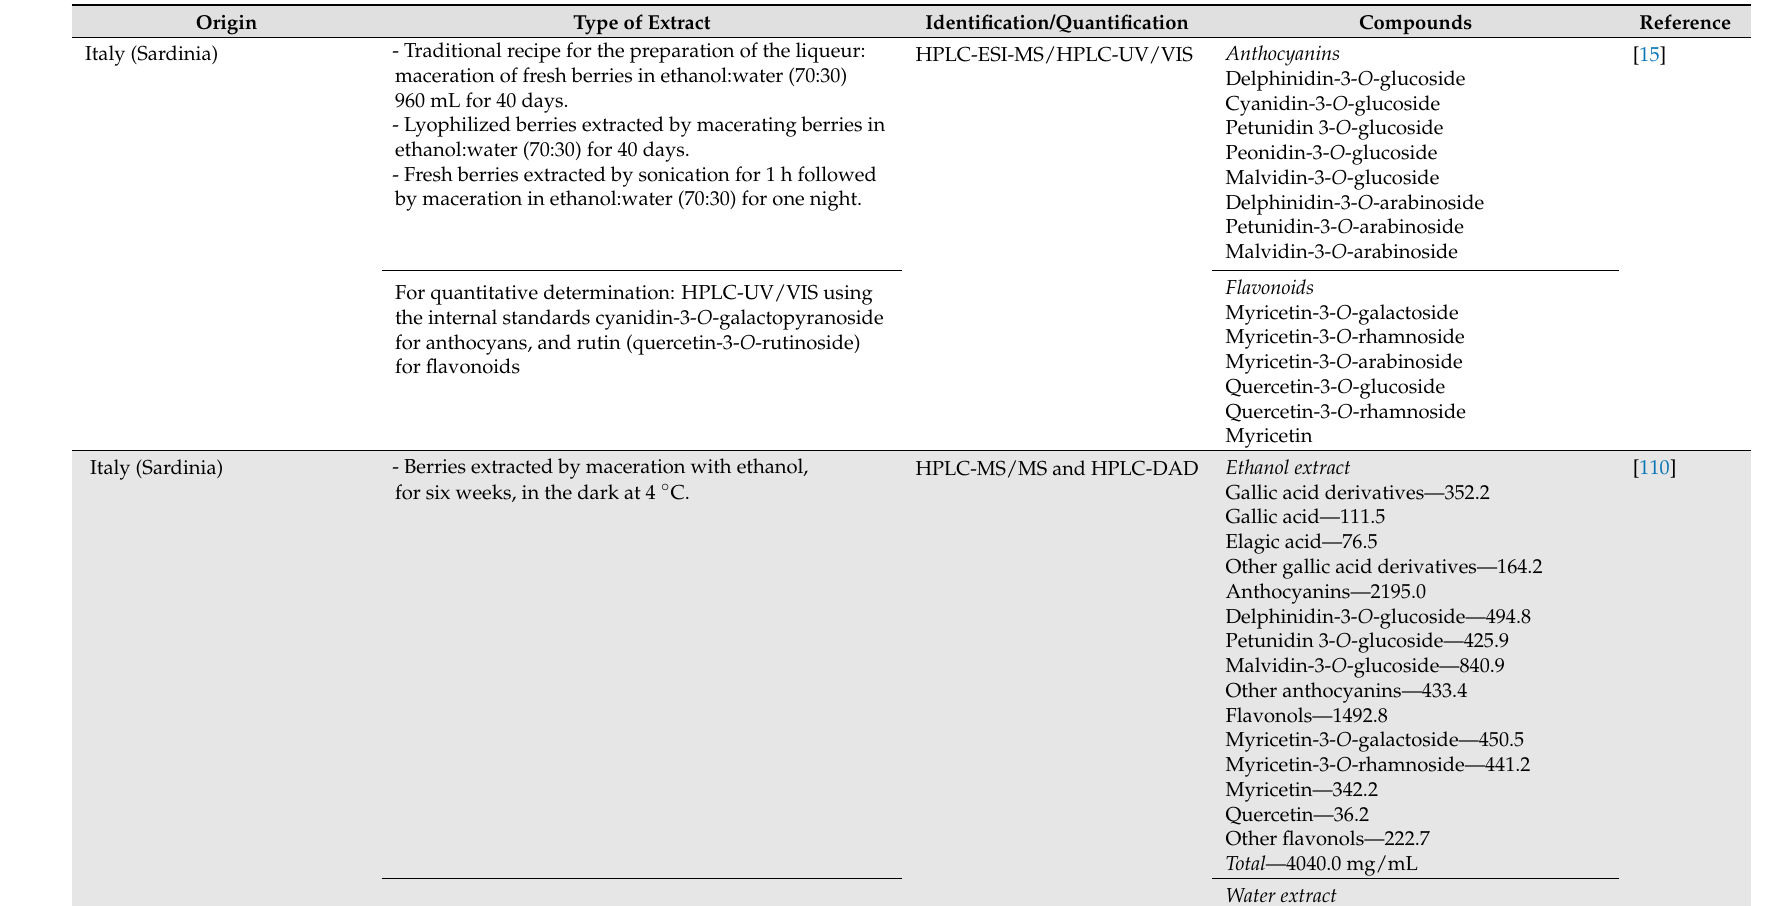
Table 2. Phenols, flavonoids and anthocyanins in berry myrtle liqueurs and berry myrtle